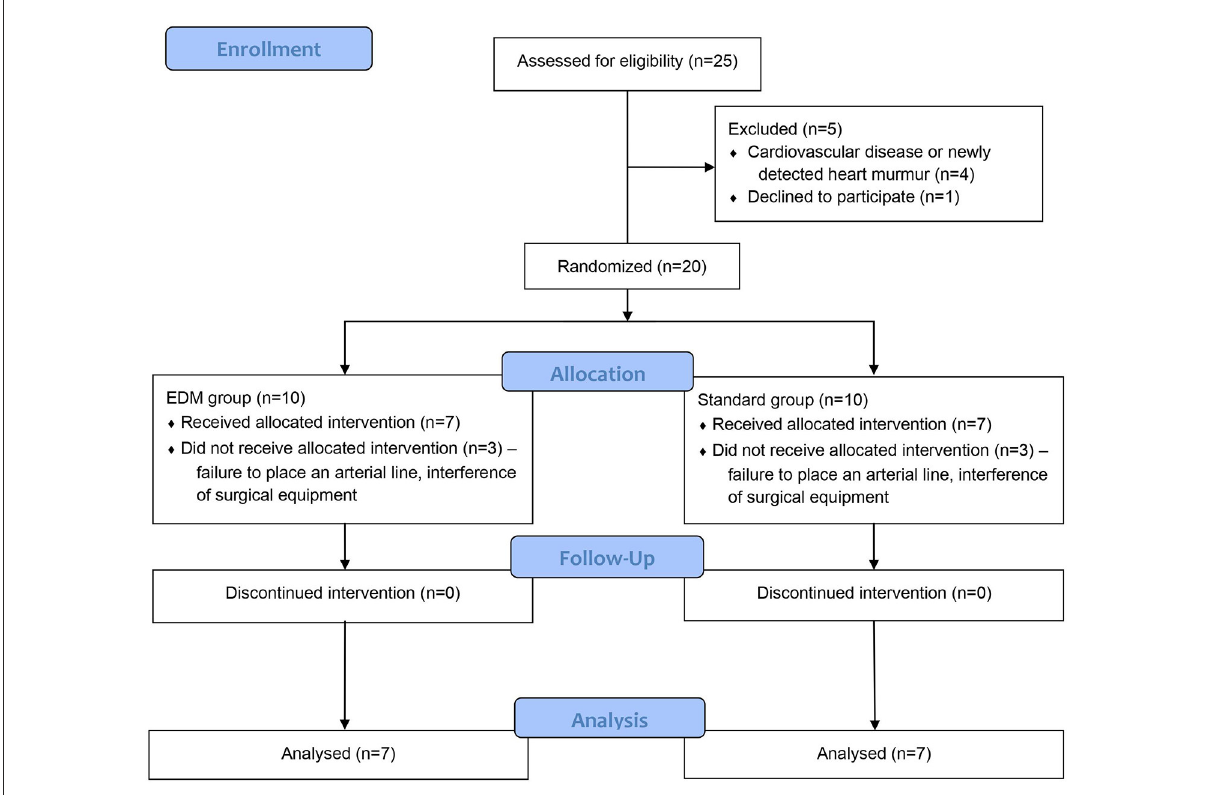
FIGURE1 CONSORT flow diagram of veterinary patient enrollment and outcomes. Group esophageal Doppler monitor (EDM): fluid management during anesthesia was conducted according to an algorithm based on EDM variables. Group standard: fluid management during anesthesia was conducted according to an algorithm based on the standard parameters heart rate and mean arterial blood